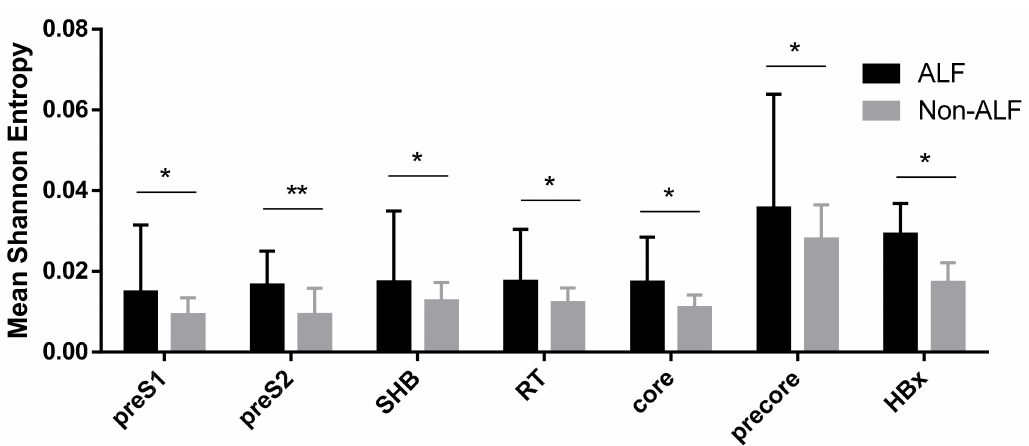
Figure 2. The small hepatitis B surface protein (SHB), preS1, preS2, reverse transcriptase (RT), precore, core, and HBx regions were next-generation sequencing (NGS) sequenced. The mean Shannon entropy values were calculated for each viral genomic region for patients with HBV reactivation with and without liver failure. Results are presented as median (IQR). Patients with liver failure had consistently higher values in all evaluated regions (preS1, preS2, SHB, RT, precore, core, and HBx). The comparison between the two groups was performed using the Mann–Whitney U test. SHB = small hepatitis B surface protein, RT = reverse transcriptase, * = p < 0.05, ** = p <